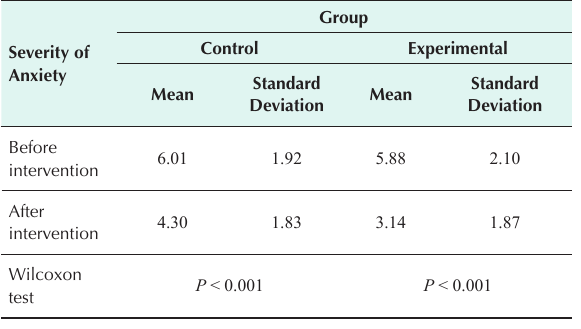
Severity of Anxiety